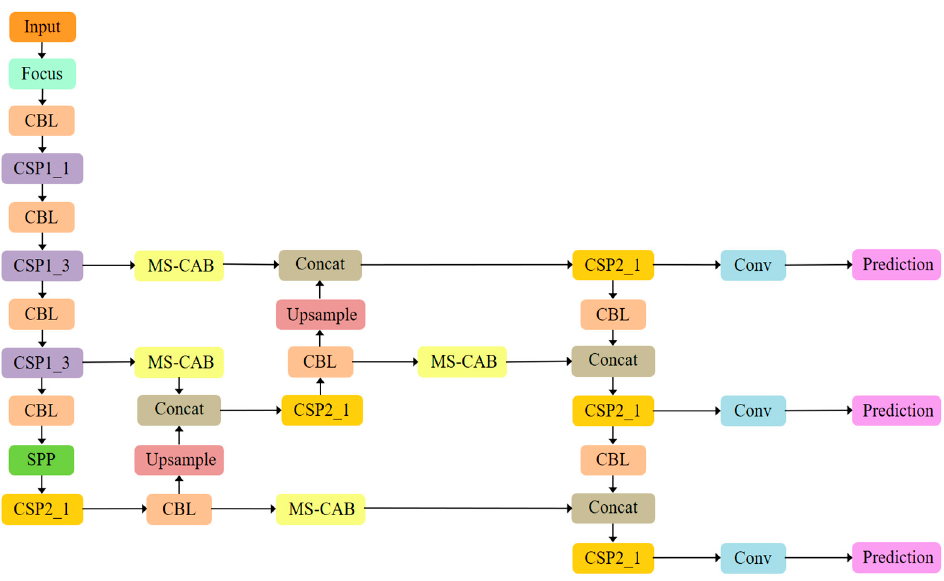
Figure 2. The MS-CAB_YOLOv5s network structure.